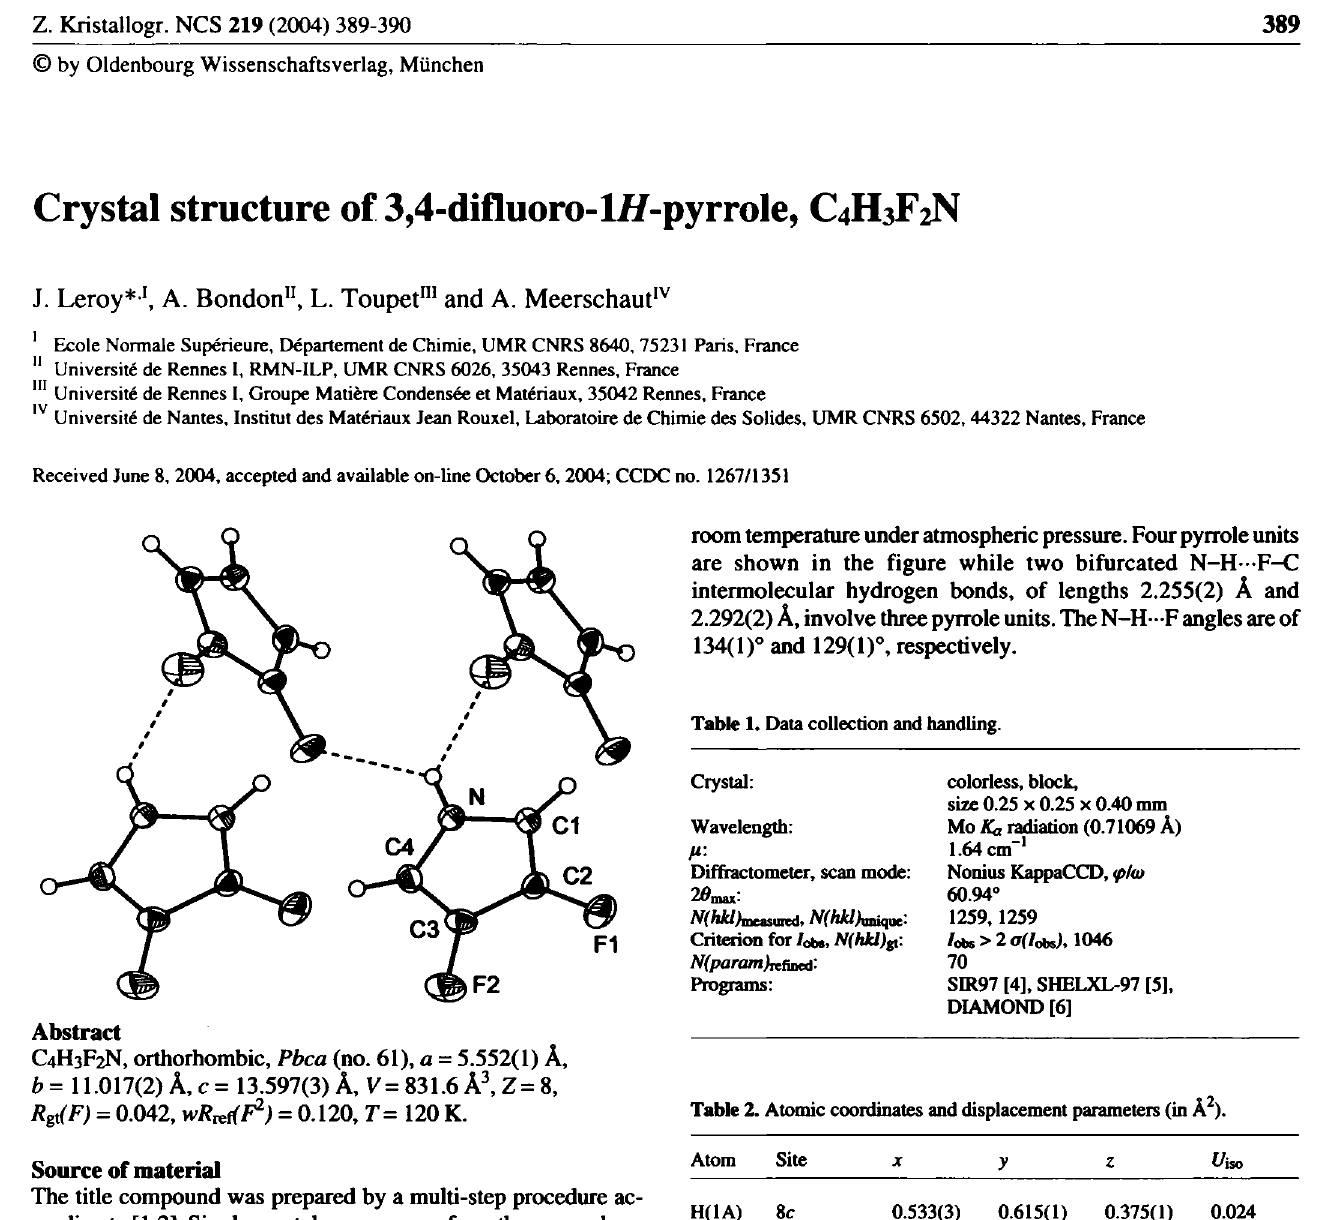
Table 2. Atomic coordinates and displacement parameters (in Â 2